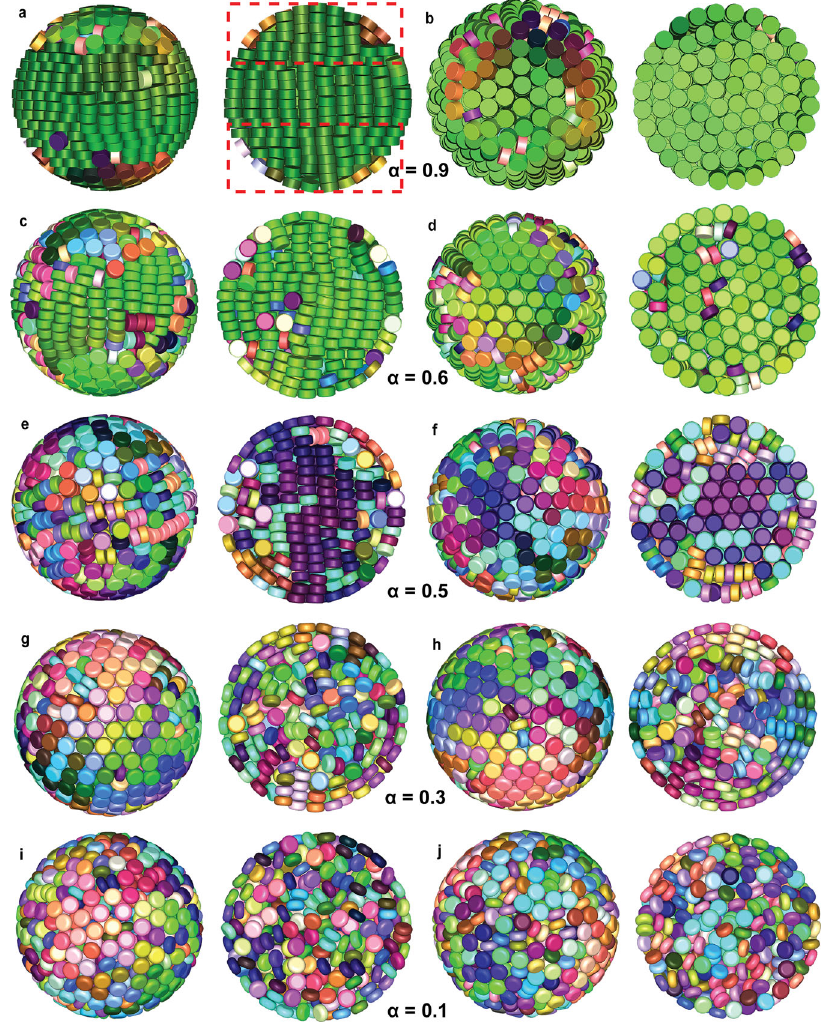
Fig. 3 | Clusters from computer simulations with varying rounding parameter α . Fully compressed con fi gurations as obtained from computer simulations with1000particlesinsphericalcon fi nementwithdifferentroundingparameters. a , b α =0.9, c , d 0.6, e , f 0.5, g , h 0.3, i , j 0.1, respectively. Note that all simulated clusters are viewed from two directions. The left and right column of each pair, shows a cut-through and a surface view of each simulated cluster, respectively.